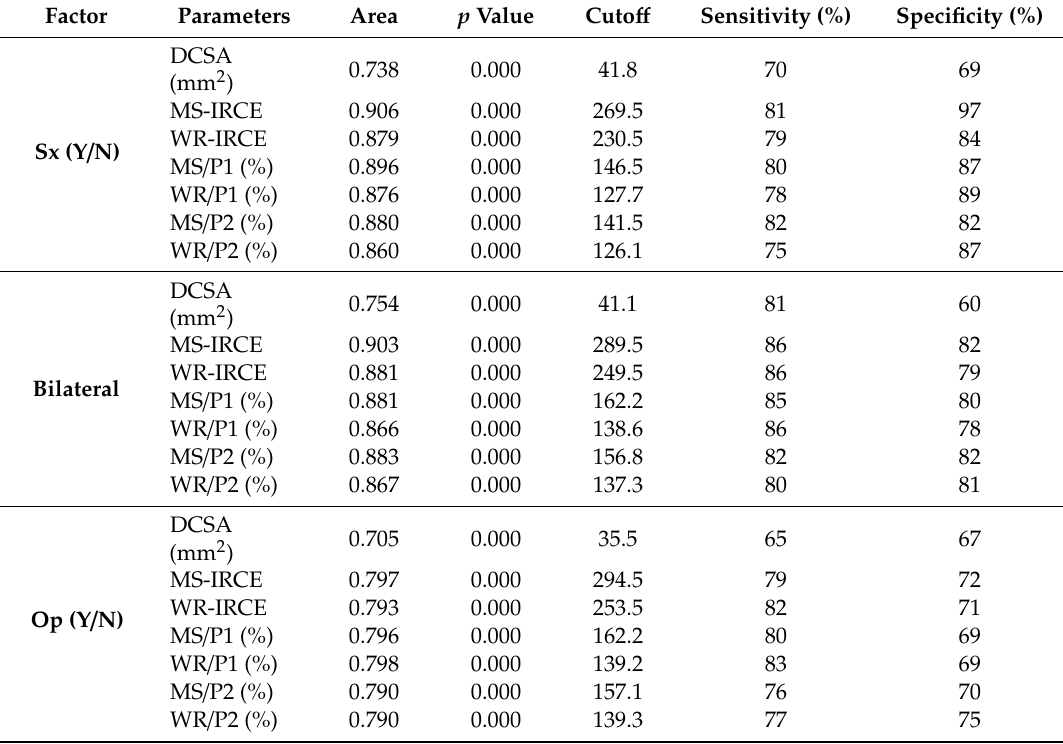
Figure 8. Receiver-operator characteristic (ROC) curve and cutoff values for the prediction of ( A ) symptom, ( B ) bilateral leg pain, ( C ) determination of operation and ( D ) visible IRCE on fat-suppressed enhanced T1-weighted axial image. Sx,—symptom, Op—operation Table 5. Cutoff values for the prediction of clinical factors.